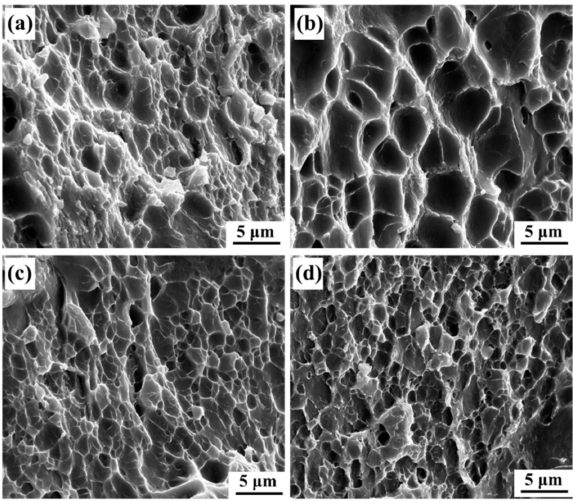
Figure 8. Fracture surfaces of the Al-10.0Mg-1.0Zn-0.15Cu (wt%) alloy: ( a ) as-rolled, ( b ) 100 ◦ C- annealed, ( c ) 150 ◦ C-annealed, ( d ) 200 ◦